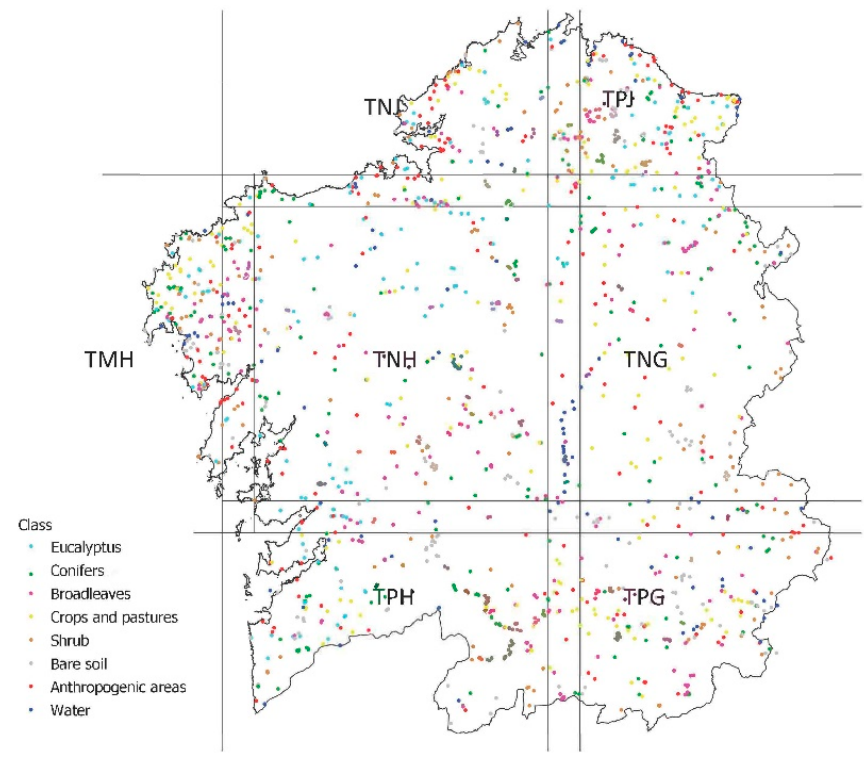
Figure 6. Distribution of verifications points.